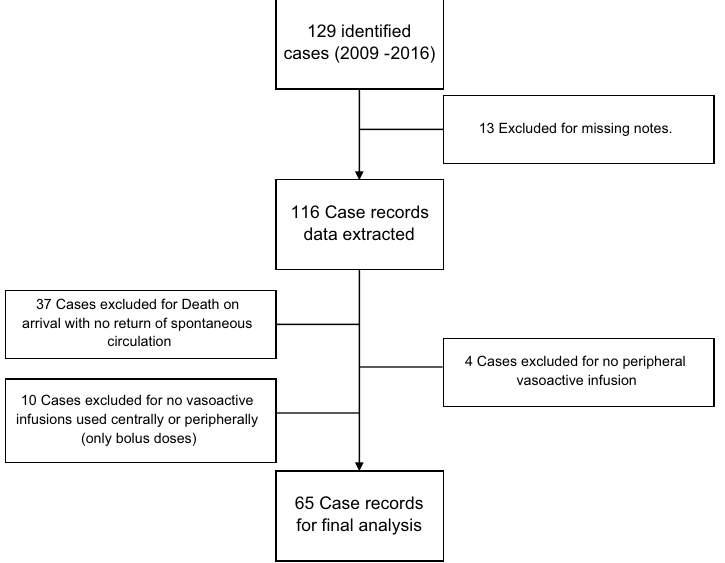
Figure 1. Strengthening the reporting of observational studies in epidemiology (STROBE) flowchart for the included patients of all patients identified with the use of vasoactive drugs in the PED.